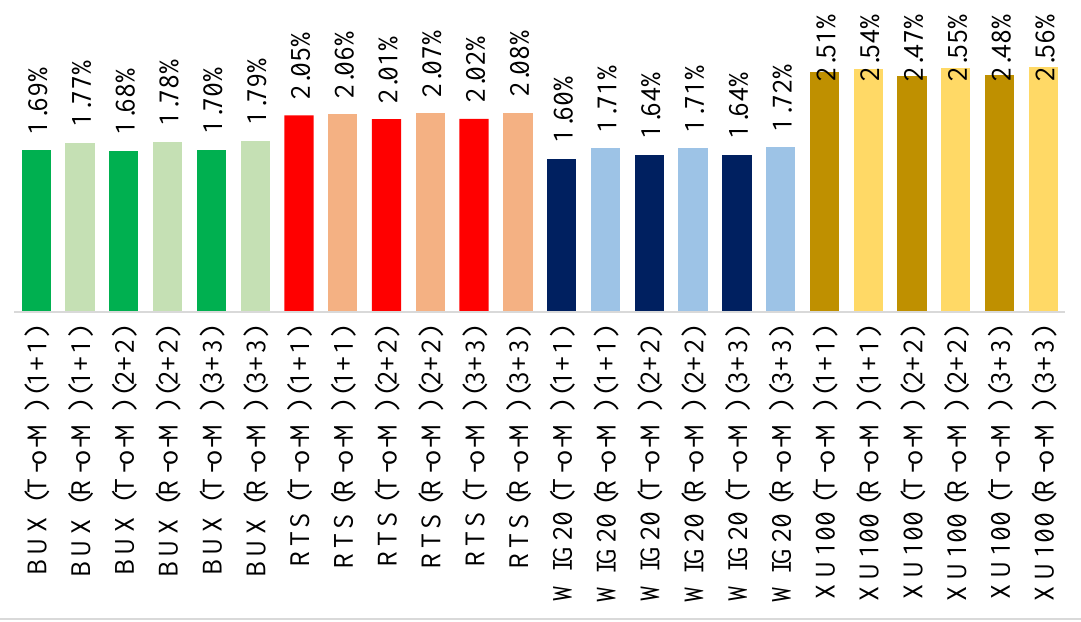
Table 5. Results of the statistical significance tests—Daily volatilities (alternative 1). Stock Index